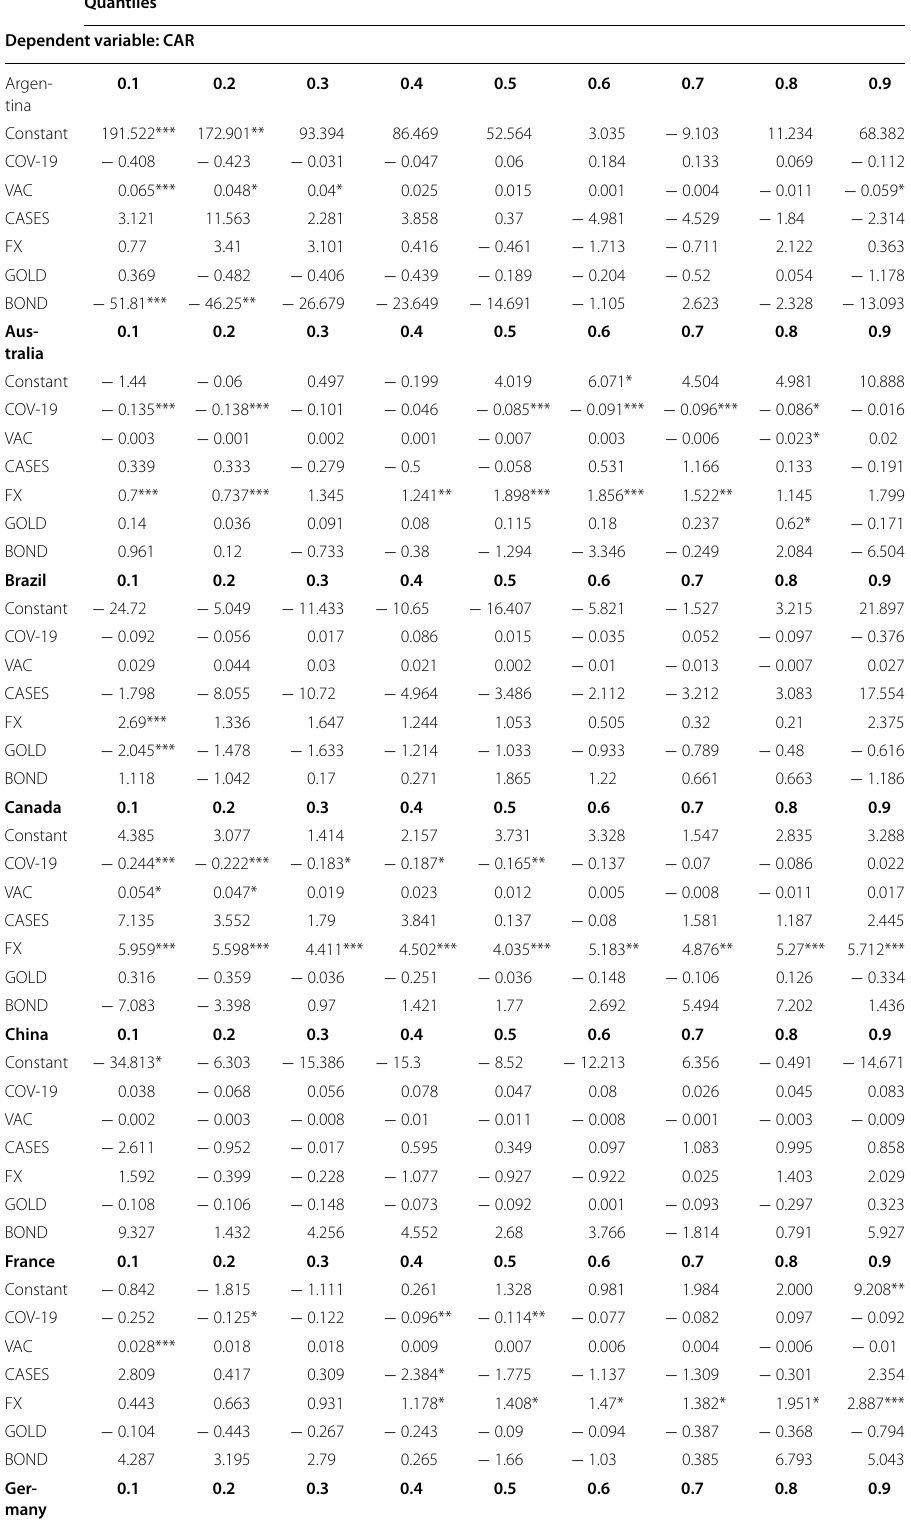
Table 13 Country quantile regression model results